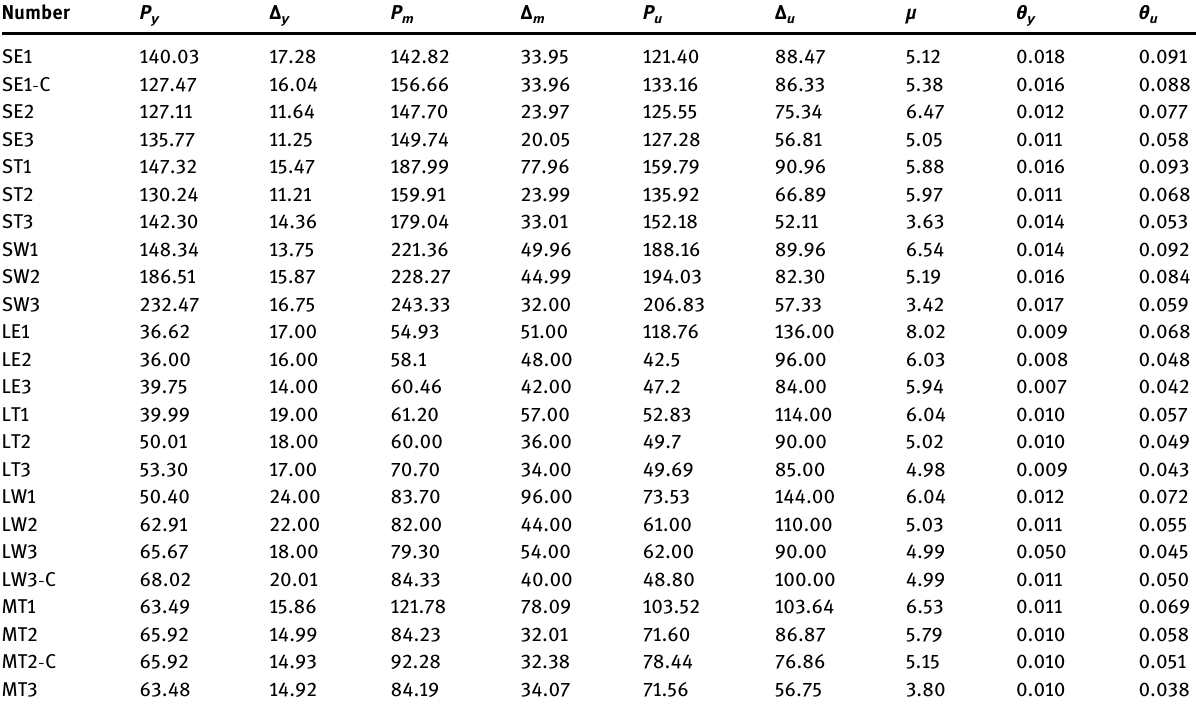
Table 9: Characteristic values of the skeleton curve of each